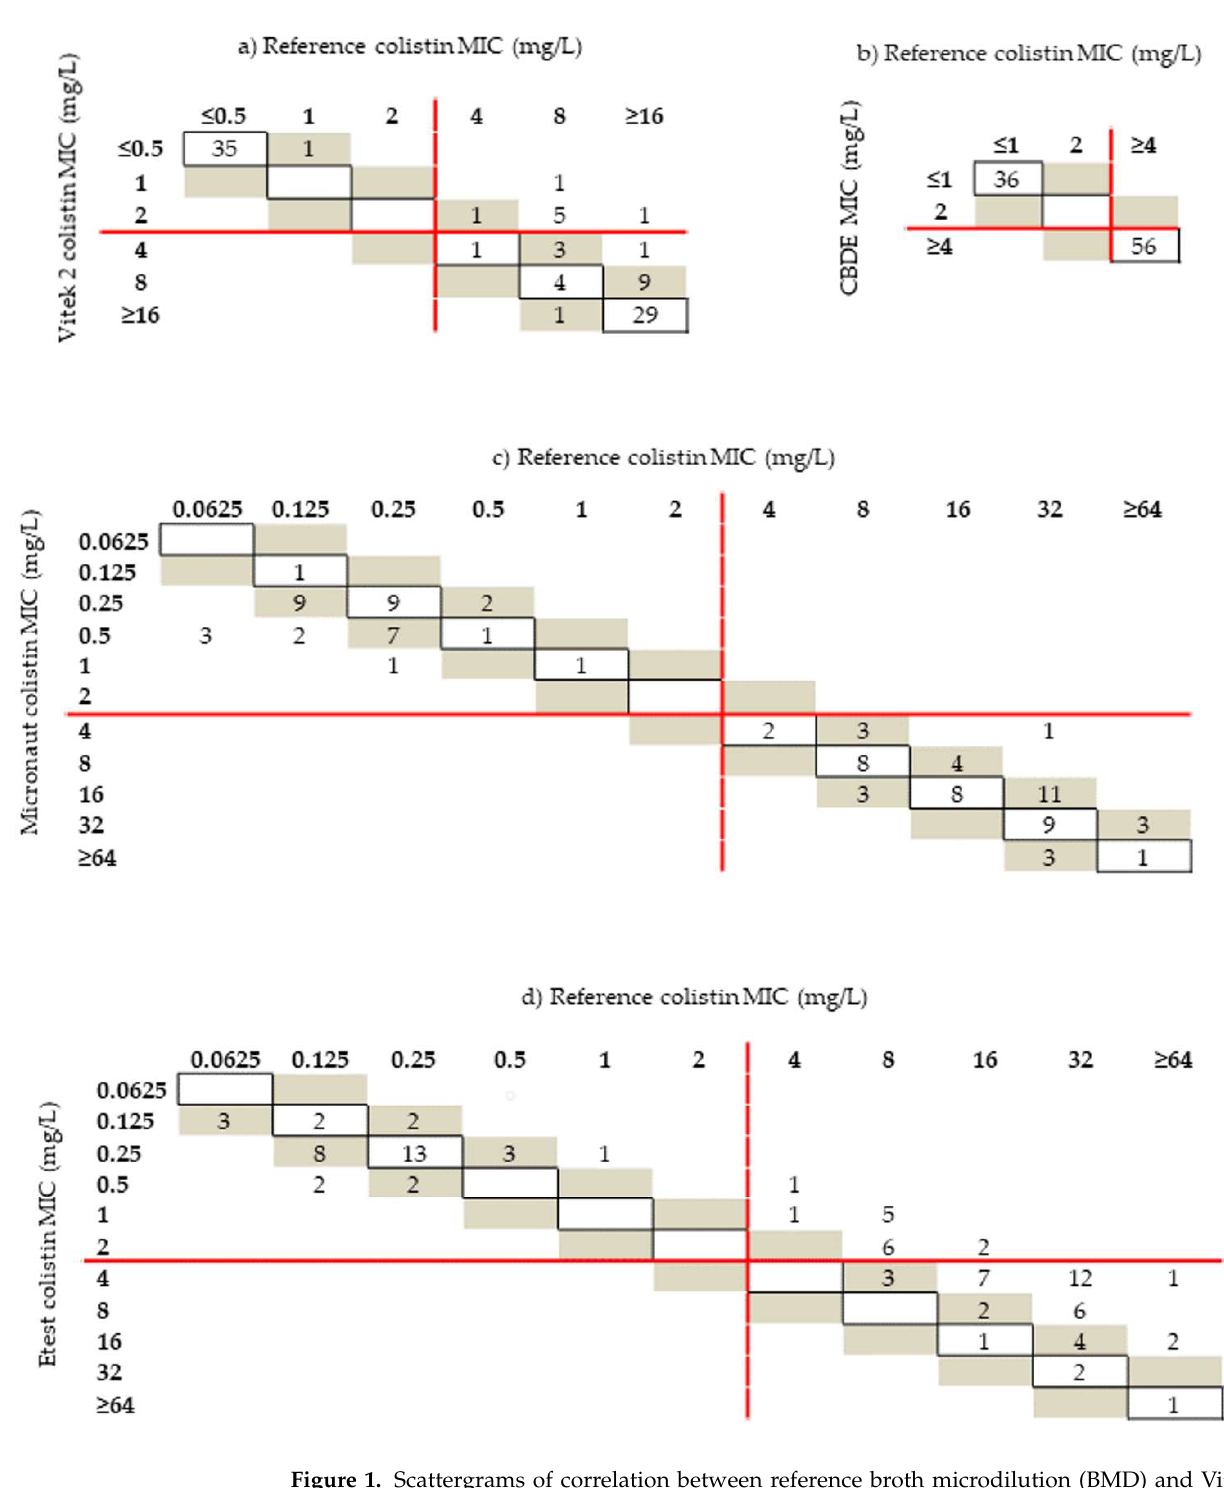
Figure 1. Scattergrams of correlation between reference broth microdilution (BMD) and Vitek 2 Compact ( a ), colistin broth disc elution (CBDE) ( b ), Micronaut MIC-Strip ( c ), and Etest ( d ) for all isolates. Minimum inhibitory concentrations (MICs) identical with those obtained by BMD and the essential agreement (EA) (MICs within ± 1 doubling dilution compared to the BMD) are mentioned as strain numbers within boxes and in shaded gray cells, respectively. The red lines represent the EUCAST breakpoints (≤2 mg/L indicates susceptibility).